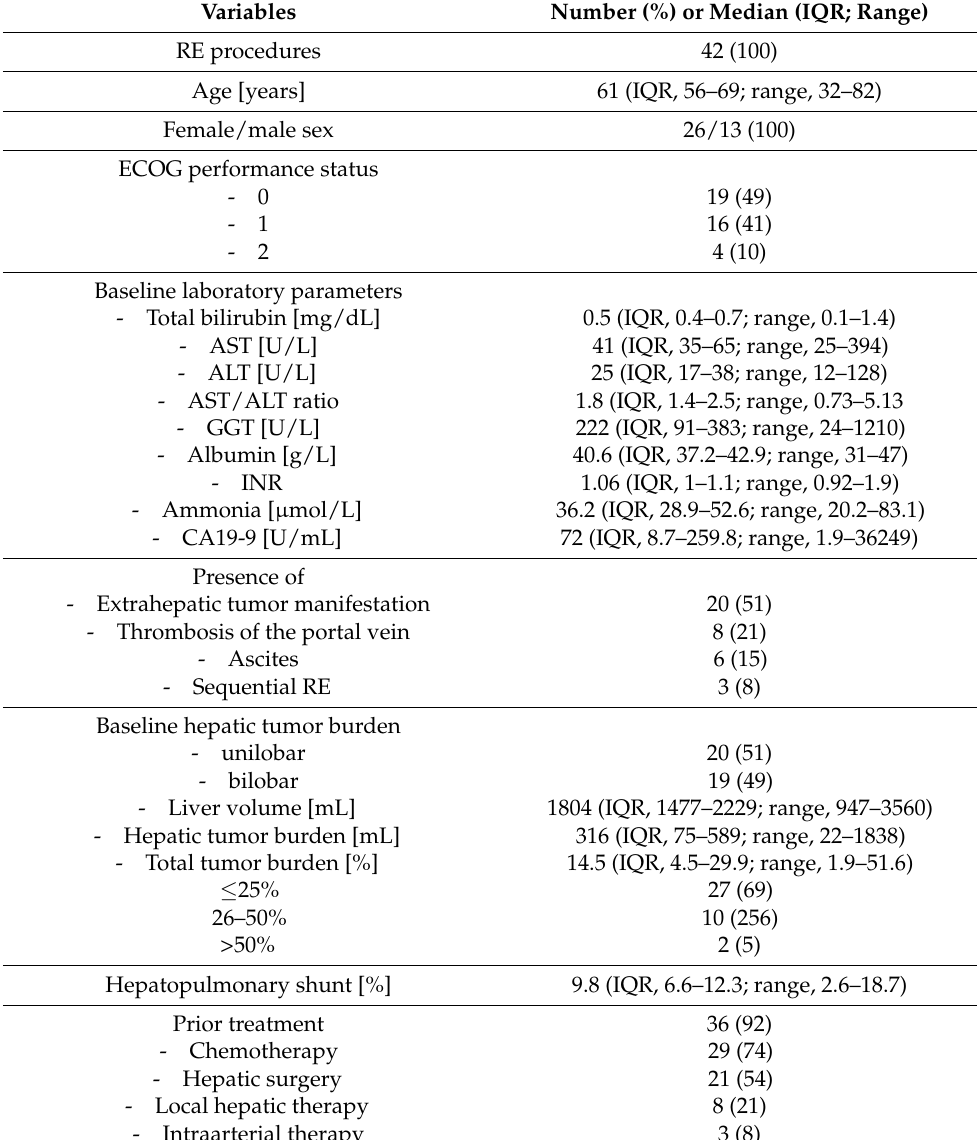
Table 1. Patient characteristics. All percentages are based on the number of patients (n = 39).